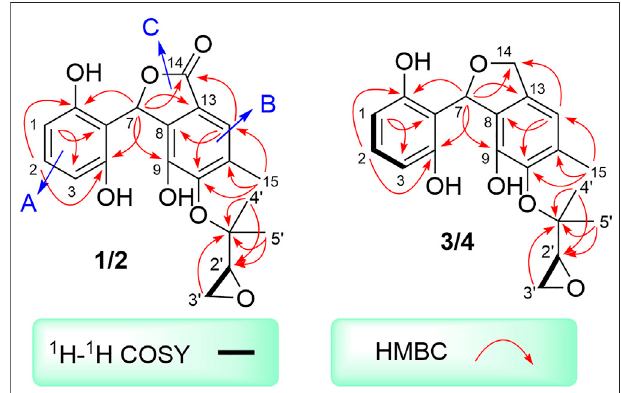
Table 2 ; HRESIMS: m / z 359.1497 [M + H] + (calcd for C 359.1489).